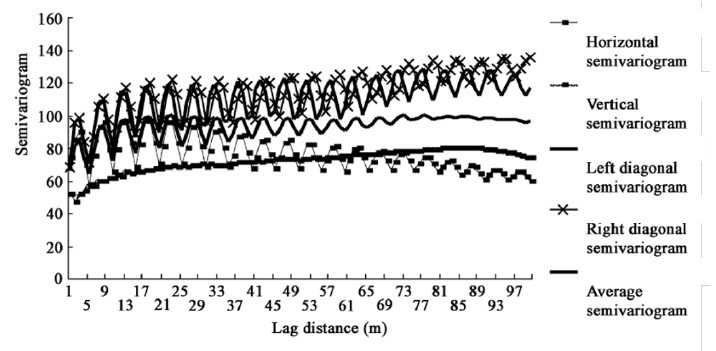
Fig. 9 The semivariance of the farmland landscape sub-area